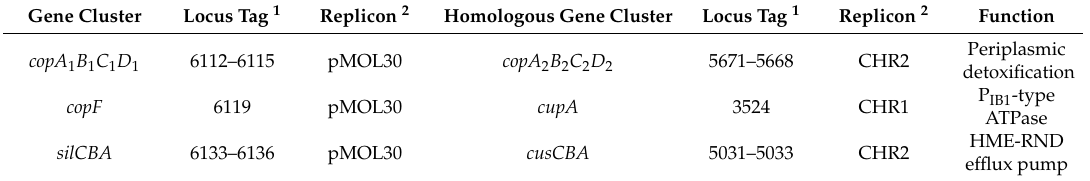
Table 1. Overview of the main Cu resistance gene clusters in Cupriavidus metallidurans CH34. Gene Cluster Locus Tag